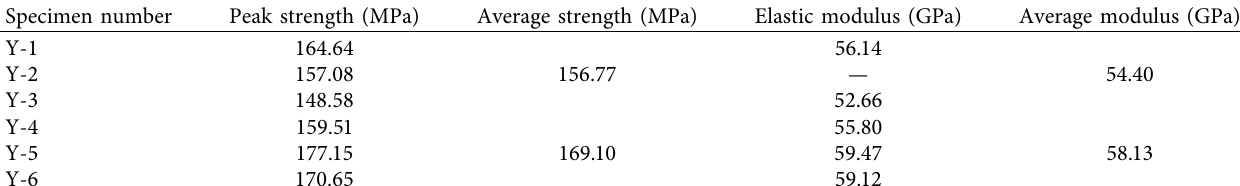
Table 2: Conventional mechanical parameters of specimen.